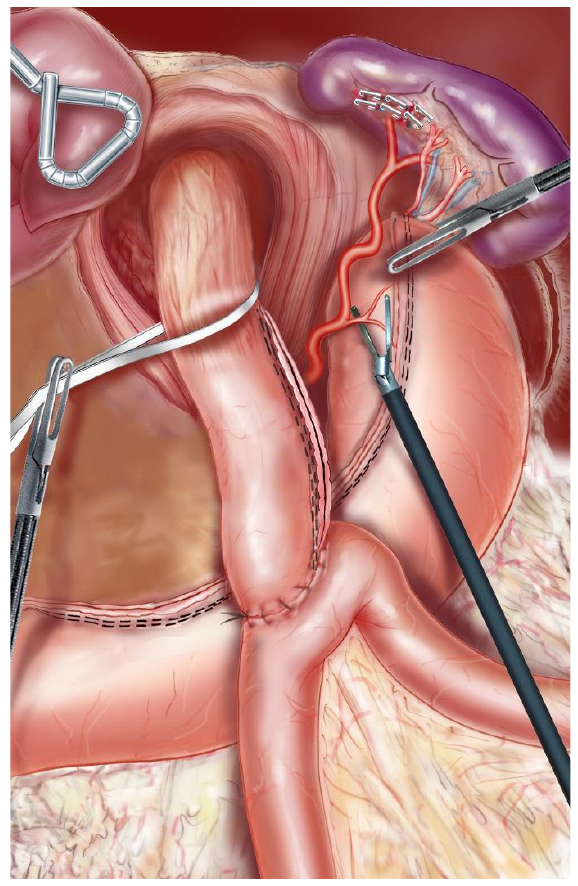
Figure 1. Dissection of the abdominal esophagus. In order to correctly mobilize the fundus, the posterior tuberosity artery and the last 2 short vessels should be systematically sectioned.